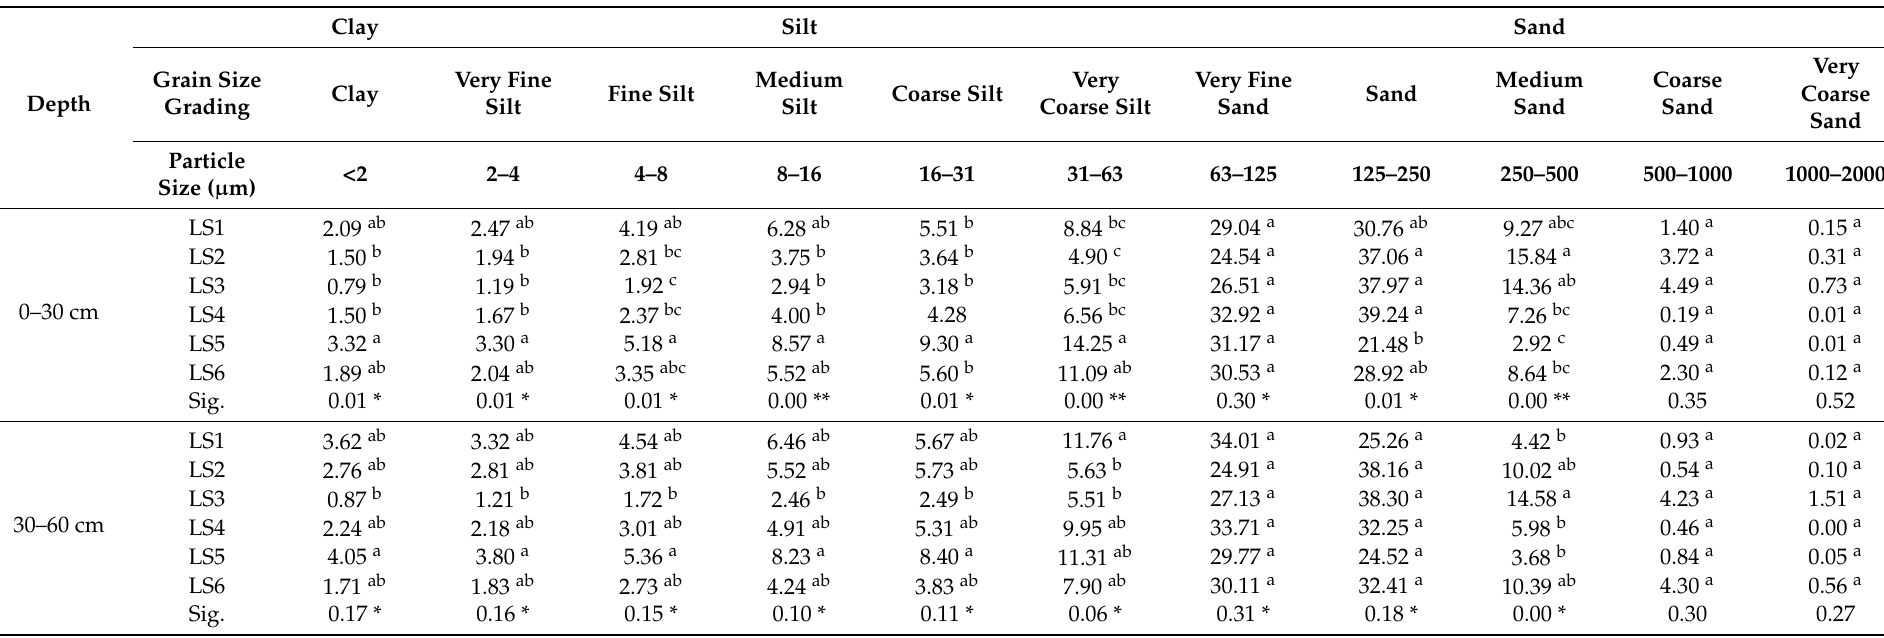
Table 2. Grain size composition of sediments collected from six landscapes (%, different letters in the same column indicate significant differences in percentage of grain size composition between different landscapes (* p < 0.05, ** p < 0.01); the significance decreases in the order of a > b >